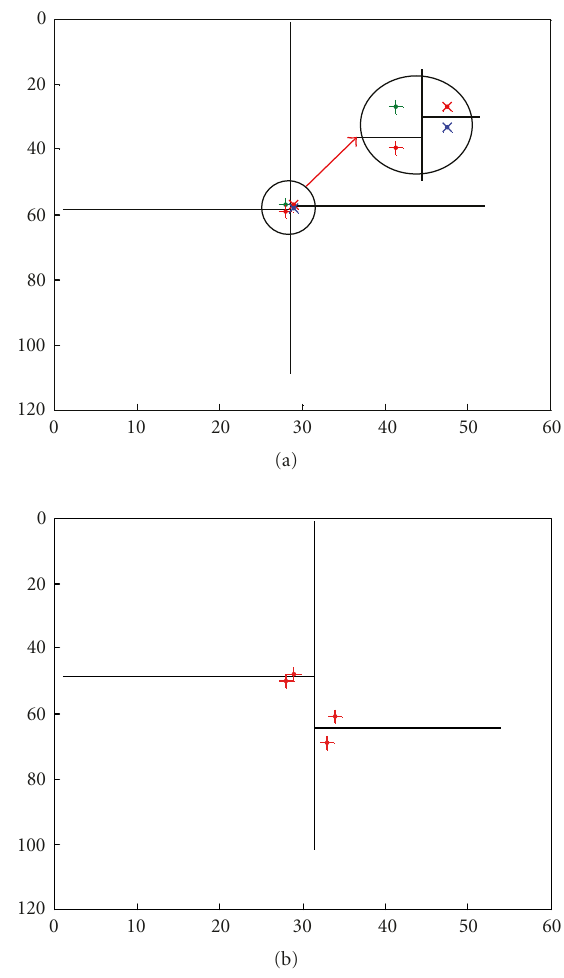
Figure 4: Dividing the voting space into four subregions. The absolute maximum in each region is found. (a) Region dividing along with the maxima related to Figure 3(a); (b) region dividing related to Figure